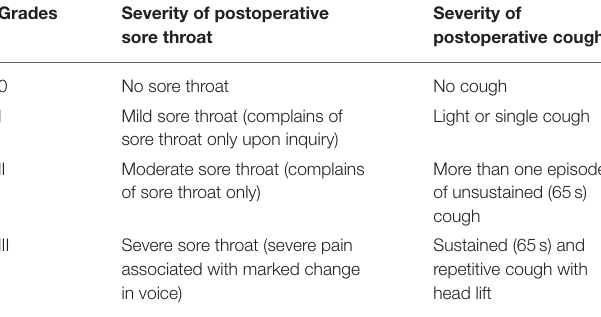
TABLE 1 | Grading system for severity of postoperative score throat and cough.